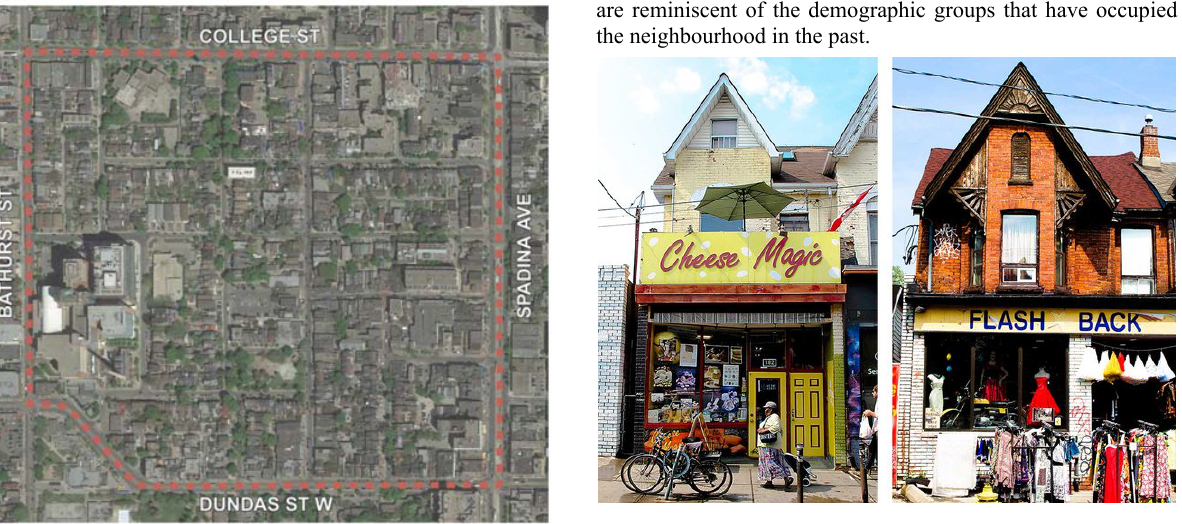
Figure 7: Kensington Market Location (Google Images)